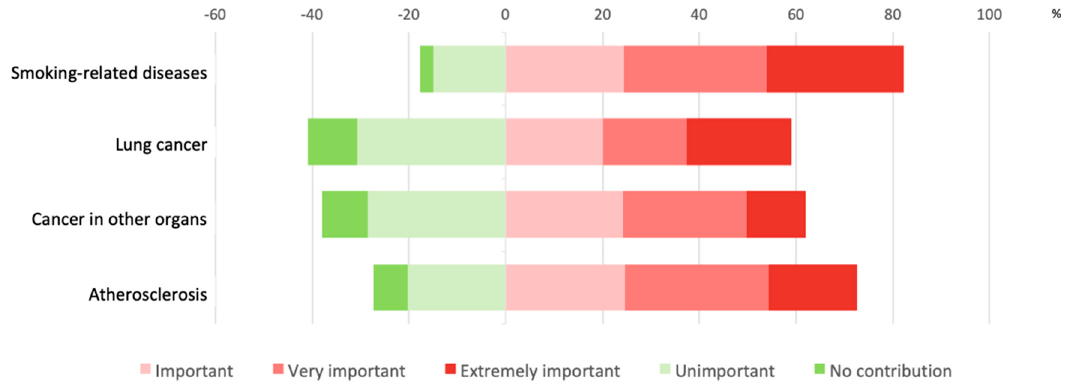
Figure 3. Stacked bar-charts indicating MRPHs’ responses on the contribution of nicotine to diseases.